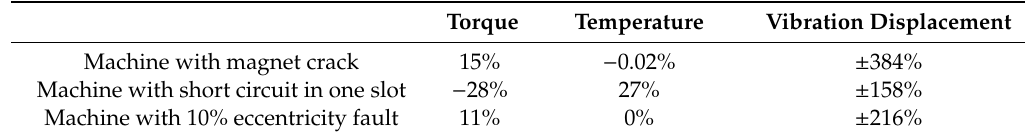
Table 3. Percentage of parameter deviation for di ff erent types of